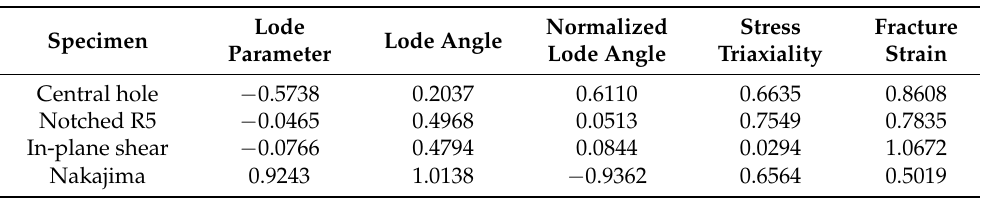
Table 10. Fracture stains, the Lode parameter, and the stress triaxiality obtained by hybrid numerical-experimental approach for 80%B + 20%M specimens.